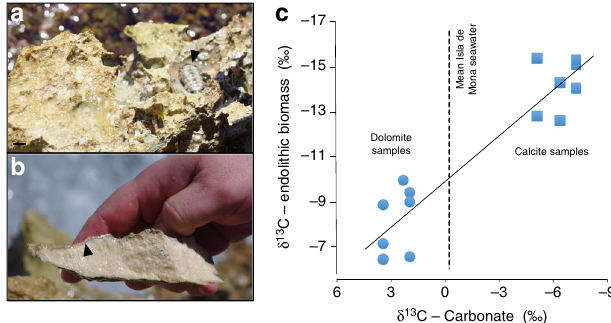
Fig. 3 Carbonate substrates containing natural endolithic communities and δ 13 C comparisons of endolith biomass against bored substrate. a Shows a typical carbonate sample substrate including a local mollusk grazer (arrowhead, Chiton sp. Polyplacophora ). Scale bar is 2 cm. b Shows a manually cracked cross section of carbonate substrate, note the boring bed just under the rock surface (arrowhead). The carbonate substrates containing natural endolithic communities were located at six discreet intertidal sites on Isla de Mona, Puerto Rico. c Shows the differential δ 13 C of organic endolithic biomass as a function of their respective substrate δ 13 C. The average mineral δ 13 C for our limestone samples was − 6.2 ± 1.1 ‰ , whereas dolomite-rich samples were more positive (2.6 ± 0.8 ‰ ); all were quite apart from local seawater DIC ( − 0.1 ‰ ), depicted by the vertical dotted line ( n = 3, s.d. = 0.005 ‰ ). A single-large infested rock fragment was coarsely cracked and three infested fragments of that were analyzed as site replicates for all but one dolomite site (very low infestation). Replicates are plotted vertically in a single column for each